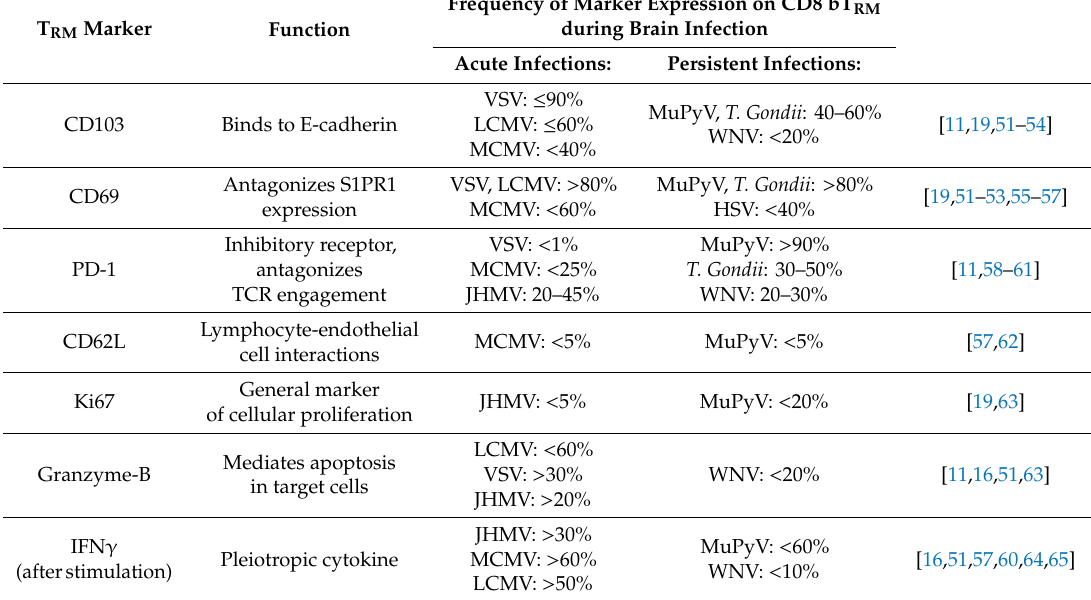
Table 1. Description and frequency of resident-memory markers on CD8 bT RM during CNS viral